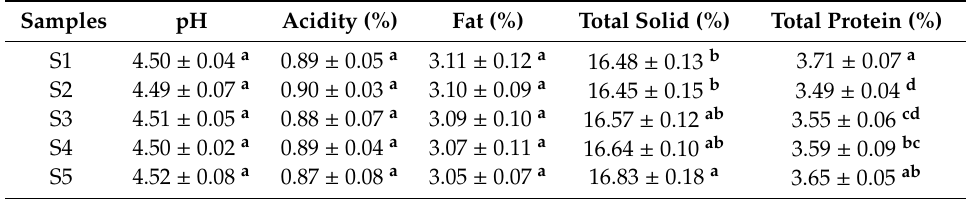
Table 1. Physiochemical parameters of yogurt samples before cold